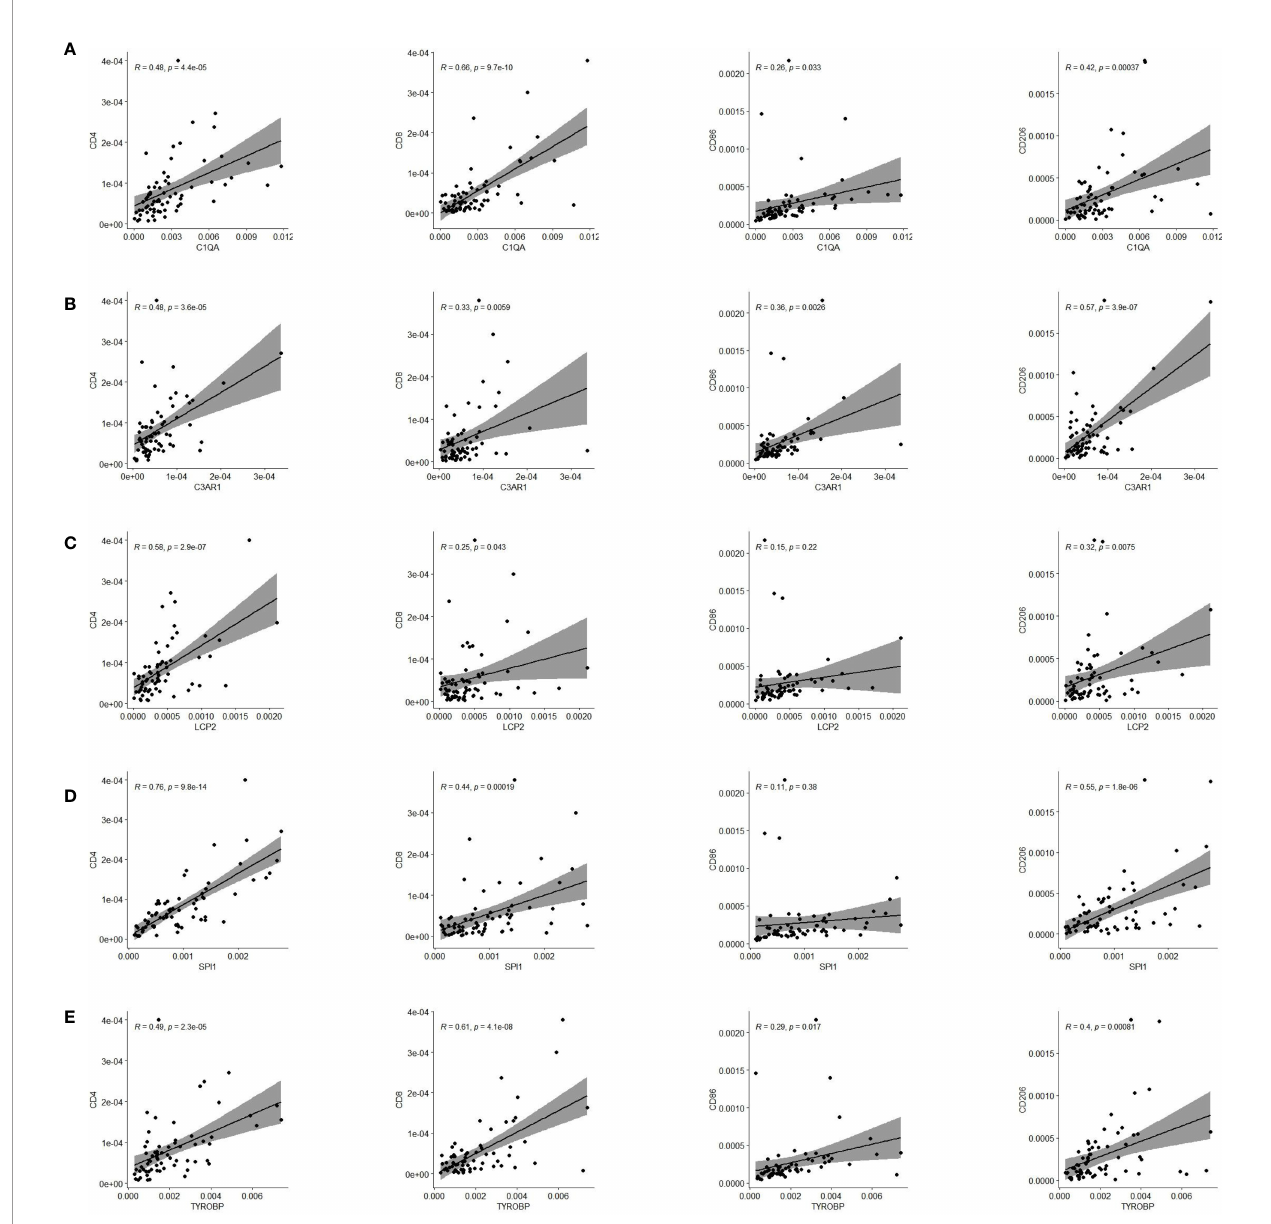
FIGURE 11 | Pearson correlation of fi ve genes expression and immune cells surface biomarkers. (A) C1QA is tightly related to CD4, CD8 and CD206. (B) C3AR1 is signi fi cantly correlated with CD4 and CD206. (C) LCP2 has close relationship with CD4 and CD206. (D) SPI1 is signi fi cantly linked with CD4 and CD206. (E) TYROBP is tightly related to CD4, CD8 and